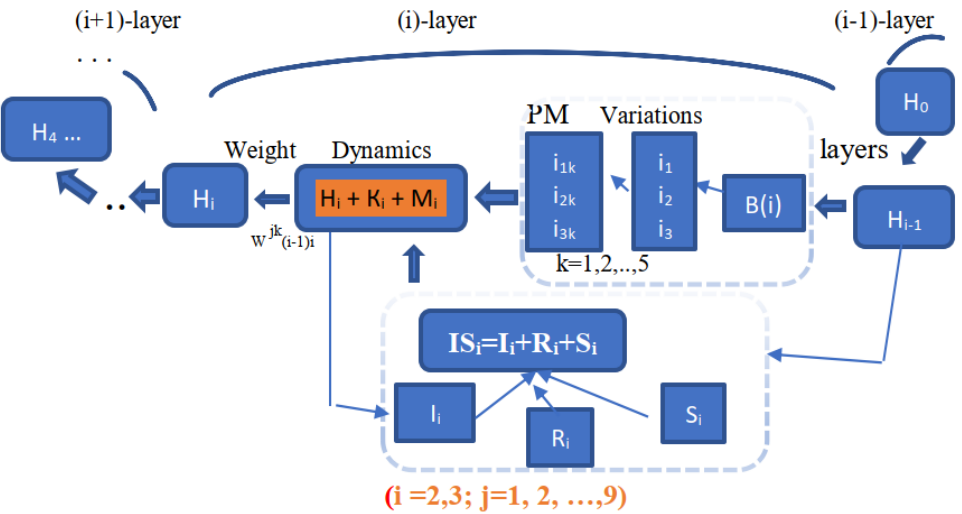
Figure 2. Interdependence of the parameters for managing the project-based and research activities of schoolchildren.